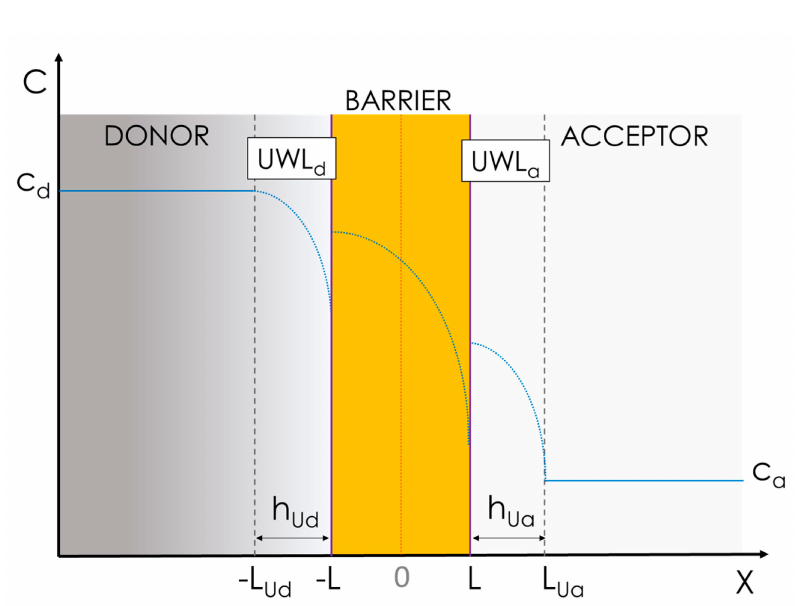
Figure 8. Advanced physical model to describe the permeation process in vitro. This model considers the existence of unstirred water layers in the donor and acceptor, namely, UWL d and UWL a , as additive thin layers that need to be crossed by the solute. Moreover, in this model, the different phases (water–lipid–water) are considered to be separated by boundary regions (interfaces, at X = − L and X =